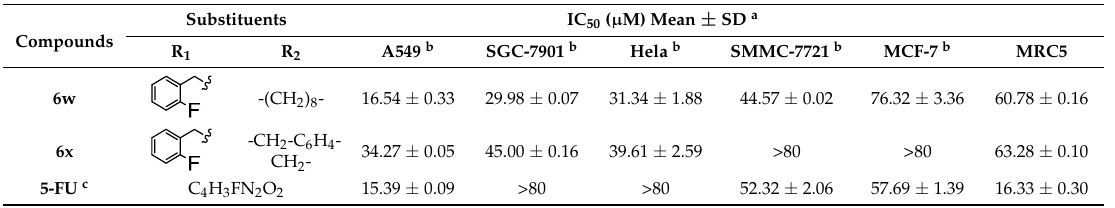
Figure 2. The cell cycle was detected by flow cytometry using PI single staining. A549 cells were treated with 4B , 6i , 4D , and 6u at 2, 4, and 8 μ M for 48 h, and then stained with PI for 30 min at 37 °C. The